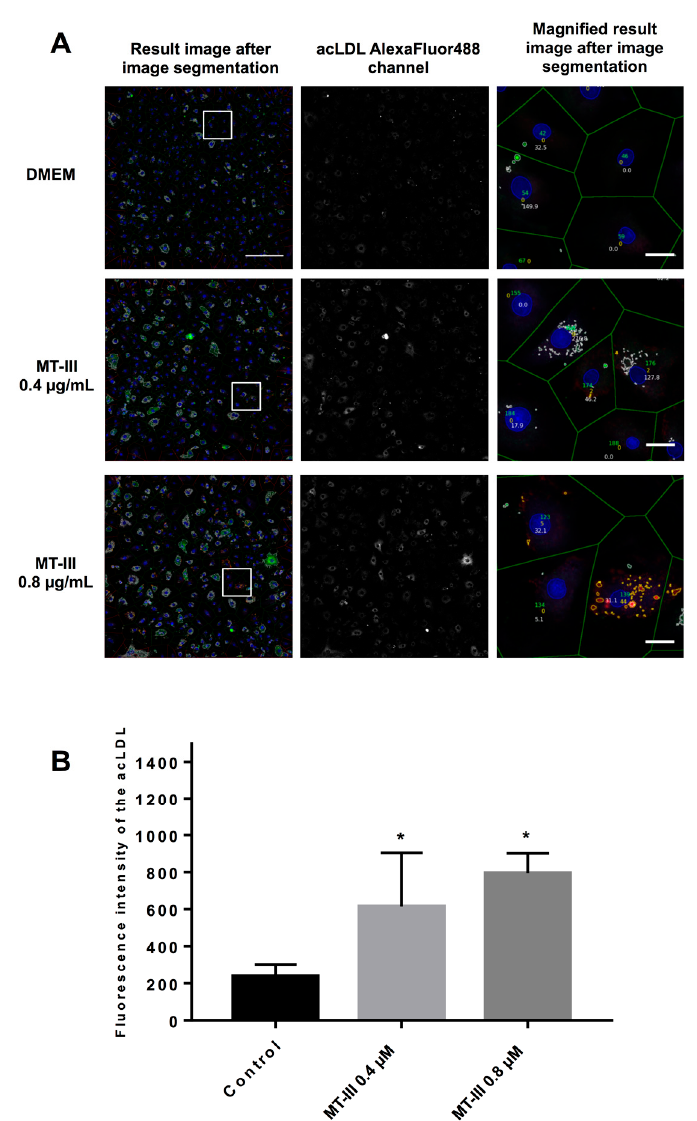
Figure 8. E ff ect of MT-III on acLDL uptake by VSMCs. ( A ) The first column illustrates the result image from the high content analysis made with the CellProfiler (scale bar 250 µ M). The second column illustrates the single channel of the incorporated AlexFluor488 labeled acLDL. The third column shows a magnified view of the result image (Scale bar 25 µ M). ( B ) Quantification of the number of Alexa Fluor 488-acLDL particles captured by VSMCs upon stimulation by the sPLA 2 MT-III. The results are expressed as the mean ± SEM from two independent experiments ( n = 6) (ANOVA). Note: * p < 0.05 compared with control cells.